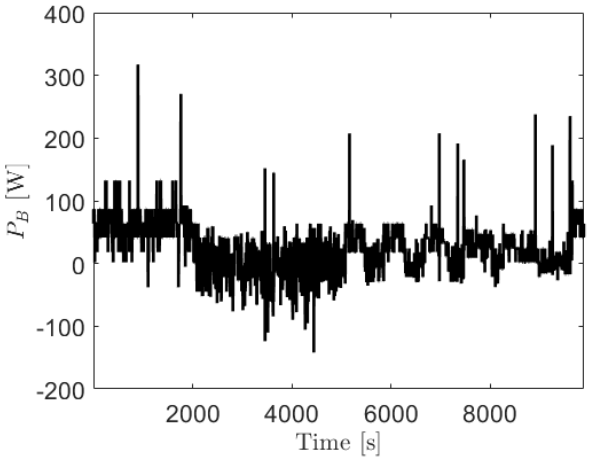
Figure 9. Fuel cell load demand power and split fraction versus time, Simulation Scenario I. The dashed and dashed-dotted lines in the top sub-figure indicate the maximum P FC with γ and = 20 deg, respectively. | |